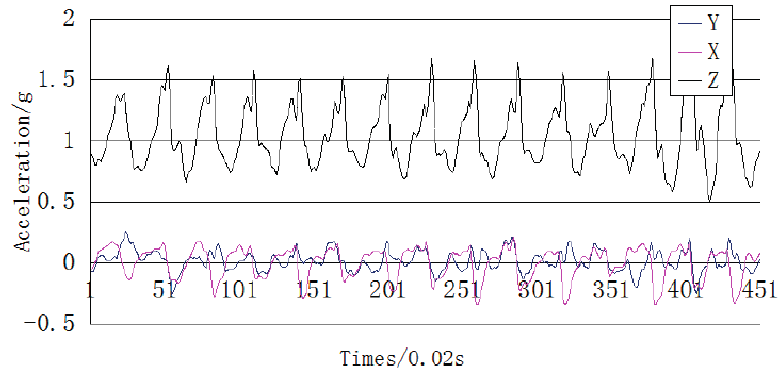
Figure 9. Three-axis acceleration of a mobile